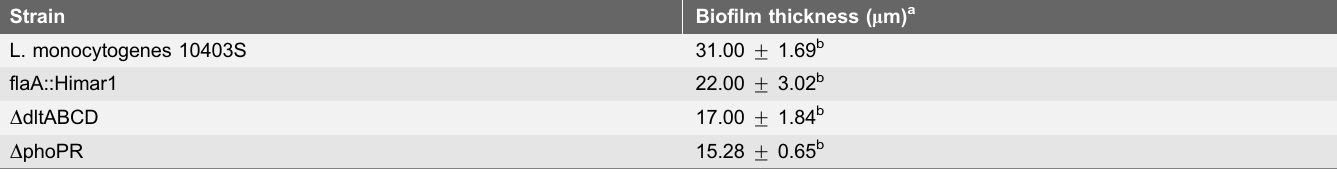
Table 2. CSLM analysis of L. monocytogenes biofilm